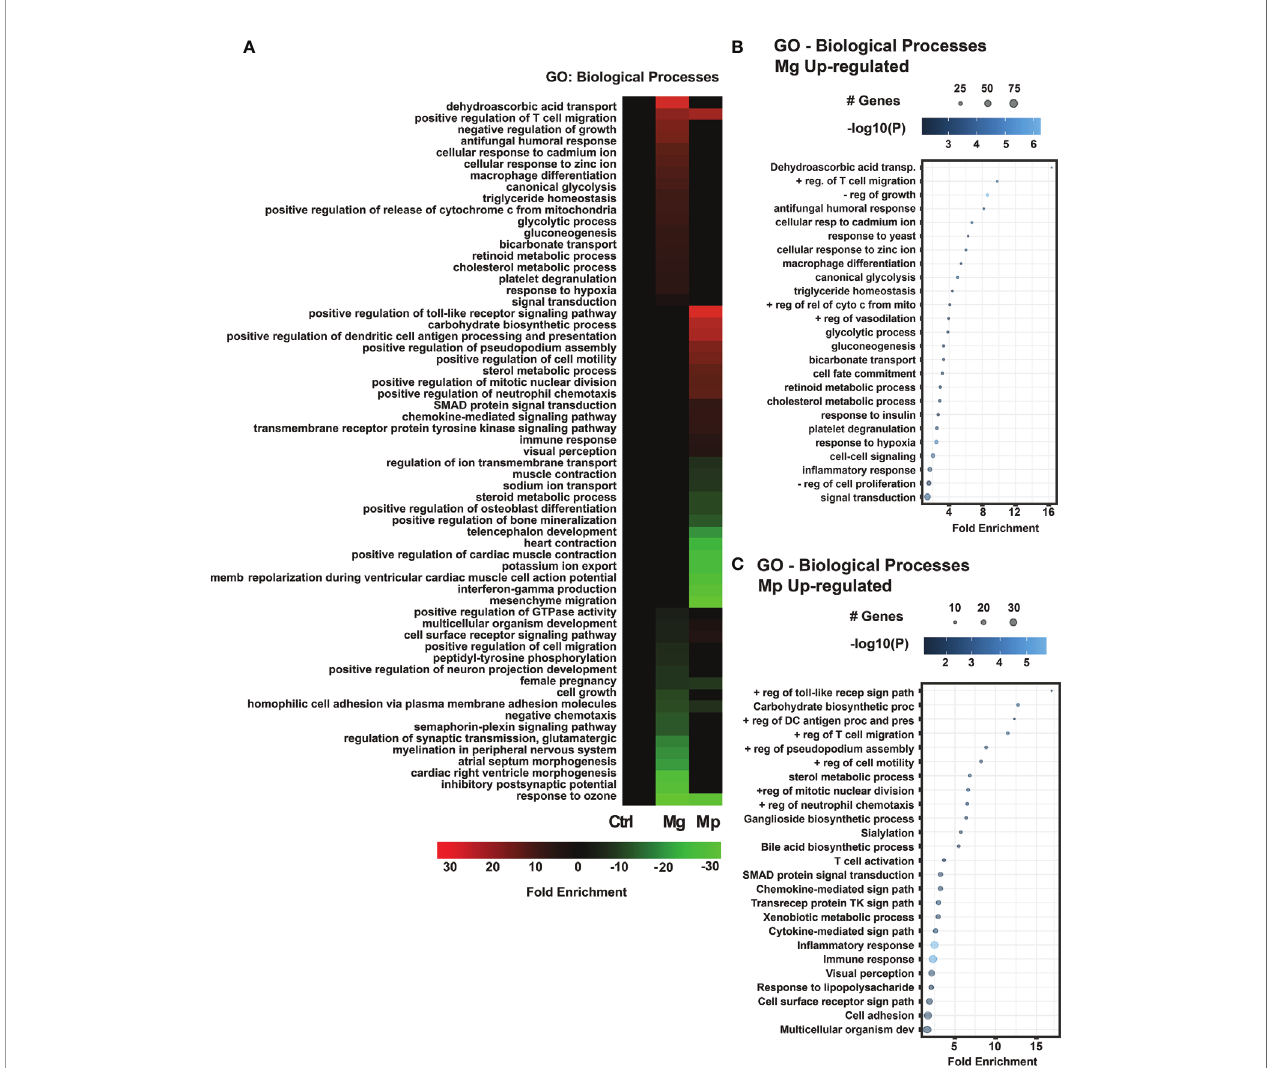
FIGURE 4 | GO Biological processes enrichment analysis for M. genitalium (Mg) and M. pneumoniae (Mp). (A) GO Biological Processes heat map showing fold enrichment pro fi les in Mg and Mp. (B) Dot blot for the enriched biological process of differentially expressed up-regulated genes in Mg. (C) Dot blot for the enriched biological process of differentially expressed up-regulated genes in Mp. Dot blots measure fold enrichment of the pathways, dot size represents total number of genes included in each category, and gradient color shows statistical signi fi cance [-log 10 ( P